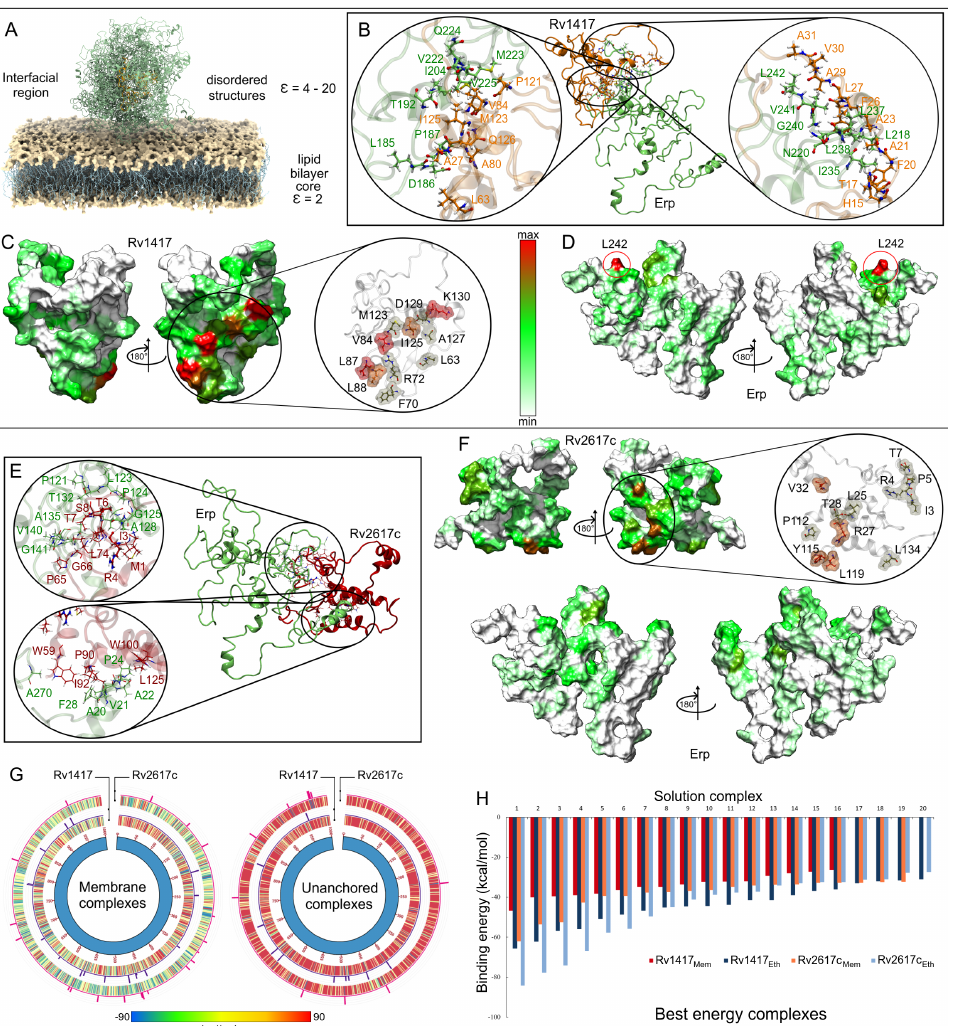
Figure 8. Contact analysis of the unanchored heterodimers under semi-polar conditions. ( A ) Repre- sentation of the location of the Erp–RvPs complexes. The dielectric constant value on the environment on the membrane surface was considered close to 20, which is an approximate value to that of the ethanol at 309.65 K (23.58). ( B , E ) Interactions on the protein interface for the best energy complexes in both Erp–RvPs couplings. The same color scheme was used to depict the protein residues of the previ- ous figures. ( C , D , F ) Heat maps of the contact frequencies mapped on the final structures obtained in the MD semi-polar simulations. ( G ) Energy comparison of the 1000 best-ranked Erp–RvPs complexes under both the membrane and semi-polar conditions. Heat maps correspond to the binding energies by complex, while histograms represent the final solutions used in contact analyses, and their bars height is the number of contacts found in a maximum of 30 contacts. ( H ) Binding energies of the 20 solutions used in the contact